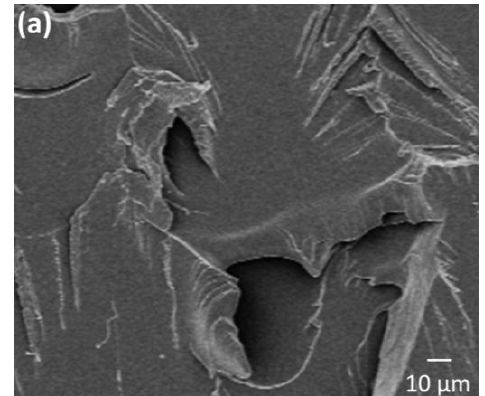
; ( c ) 1 vol% of 20k20k-SiO 2 ; ( f ) higher magnification for 1 vol% 20k20k; and ( g ) higher 2